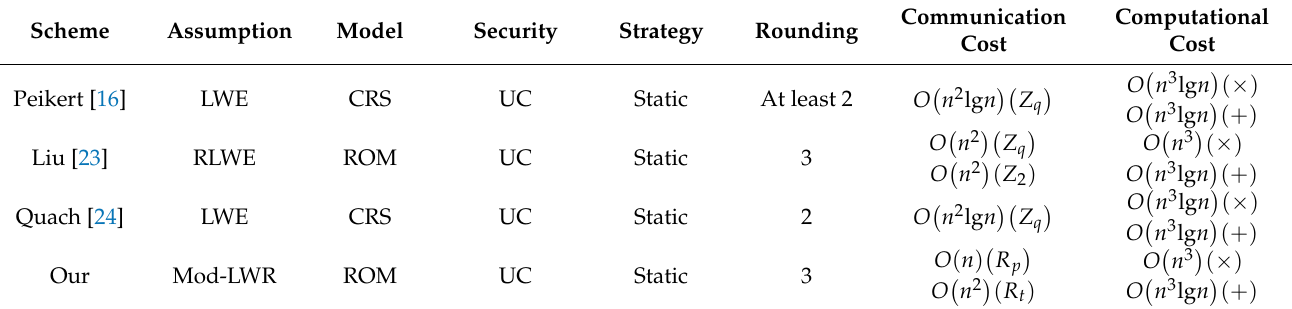
Table 6. Comparison with other OT